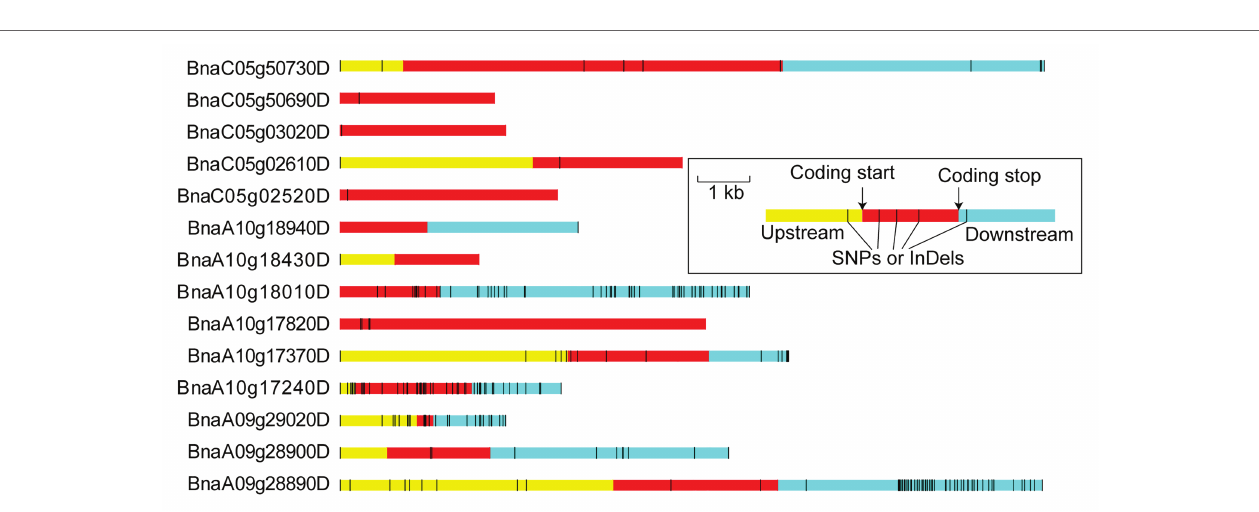
FIGURE 4 | Analysis of SNPs and insertion-deletions (InDels) between both parents in the three target intervals, FTA09 (A) , FTA10 (B) , and FTC05 (C) . Strip-shape charts show the distribution of SNPs and InDels in different genomic regions. The upstream and downstream represent the 5 kb within the region of transcription start and stop sites, respectively. Pie charts show the effects of SNP (upside) and InDel (underside) in the intragenic regions. And the corresponding quantity of SNP or InDel is labeled near the pie